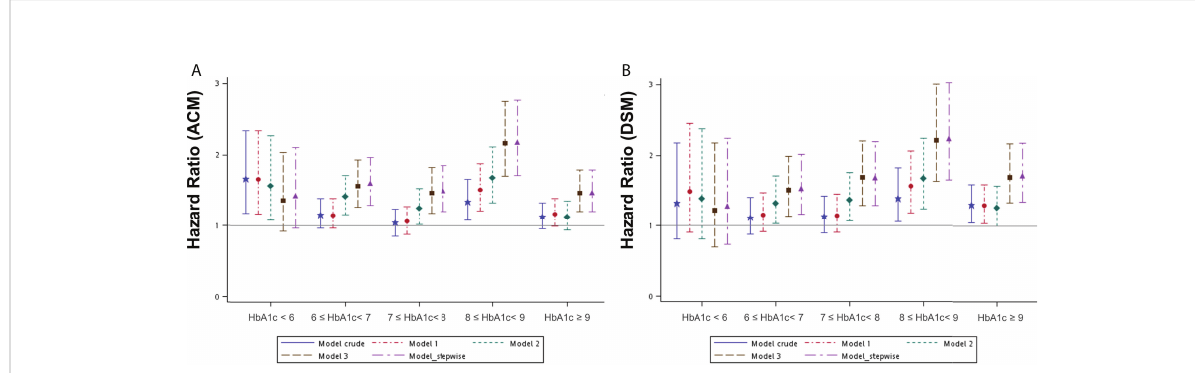
FIGURE 2 Hazard ratios for mortality events according to the different HbA1c intervals at the initial diagnosis of OSCC in patients with DM compared to patients without DM by several models. (A) ACM, all-cause mortality; (B) DSM, disease-speci fi c mortality. DM, diabetes mellitus. OSCC, oral squamous cell carcinoma Model 1 was adjusted for age, sex, tumor site, and clinical AJCC stages of cancer. Model 2 was adjusted for the variables in model 1 plus BMI, lifestyle risk factors, and treatment. Model 3 was adjusted for the variables in model 2 plus comorbidities and medication use. Model 4_ stepwise was built with variables according to the statistical software (a stepwise